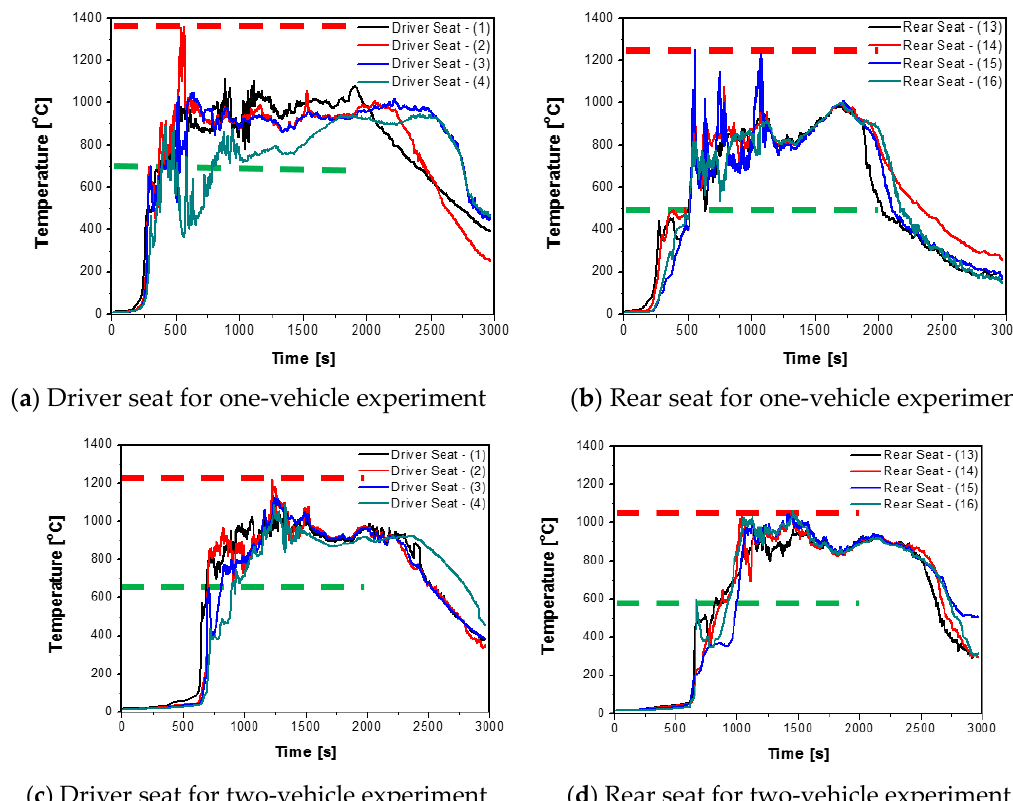
Figure 8. Temperature distribution results inside the driver and rear seats for one and two vehicles: ( a ) Temperature of driver seat inside the first vehicle for the one-vehicle experiment, ( b ) temperature of rear seat inside the first vehicle for the one-vehicle experiment, ( c ) temperature of driver seat inside the first vehicle for the two-vehicle experiment, and ( d ) temperature of rear seat inside the first vehicle for the two-vehicle experiment.